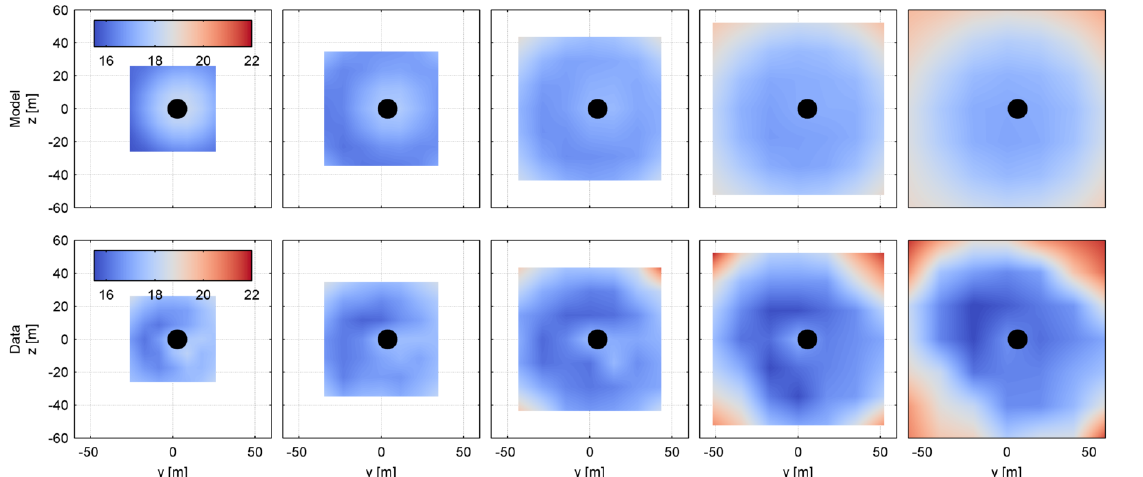
Figure 7. An example estimation step of the wake tracking. The simulated lidar measurements in the first row are compared to the measured lidar data in the second row for five downstream distances from 0.6 to 1.4 D (from left to right, [0.6, 0.8, 1.0, 1.2, 1.4], looking downstream). The estimated wake center is marked with the black